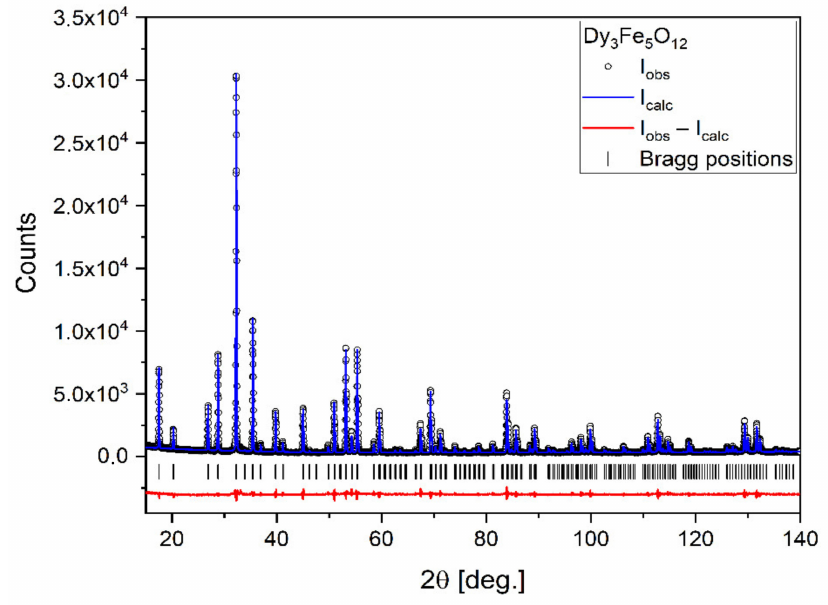
Figure 1. X-ray diffraction pattern of Dy 3 Fe 5 O 12 with results of the Rietveld